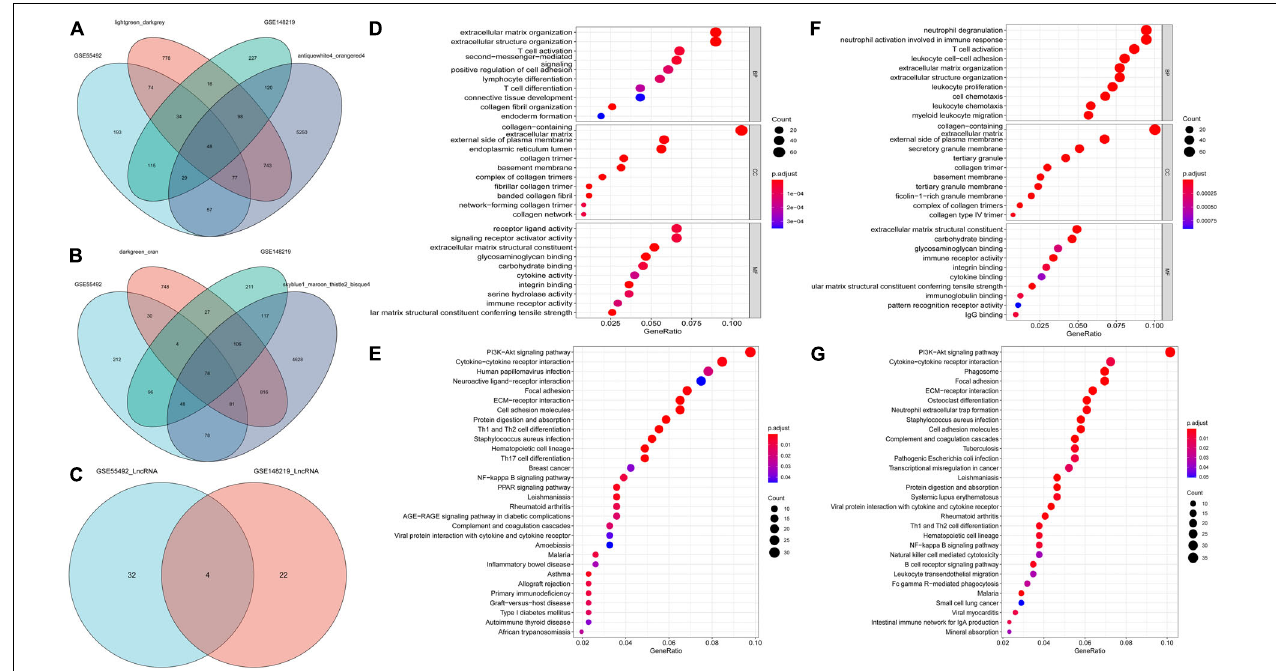
FIGURE 4 | Differentially expressed mRNAs and LncRNAs for CAVD, and the functional enrichment analysis. (A) Venn diagram for differentially expressed mRNAs and positive modules in GSE55492 and GSE148219; (B) Venn diagram for differentially expressed mRNAs and negative modules in GSE55492 and GSE148219; (C) Venn diagram for differentially expressed LncRNAs in GSE55492 and GSE148219; (D) GO analyses of differentially expressed mRNAs in GSE55492; (E) KEGG pathway analyses of differentially expressed mRNAs in GSE55492; (F) GO analyses of differentially expressed mRNAs in GSE148219; (G) KEGG pathway analyses of differentially expressed mRNAs in